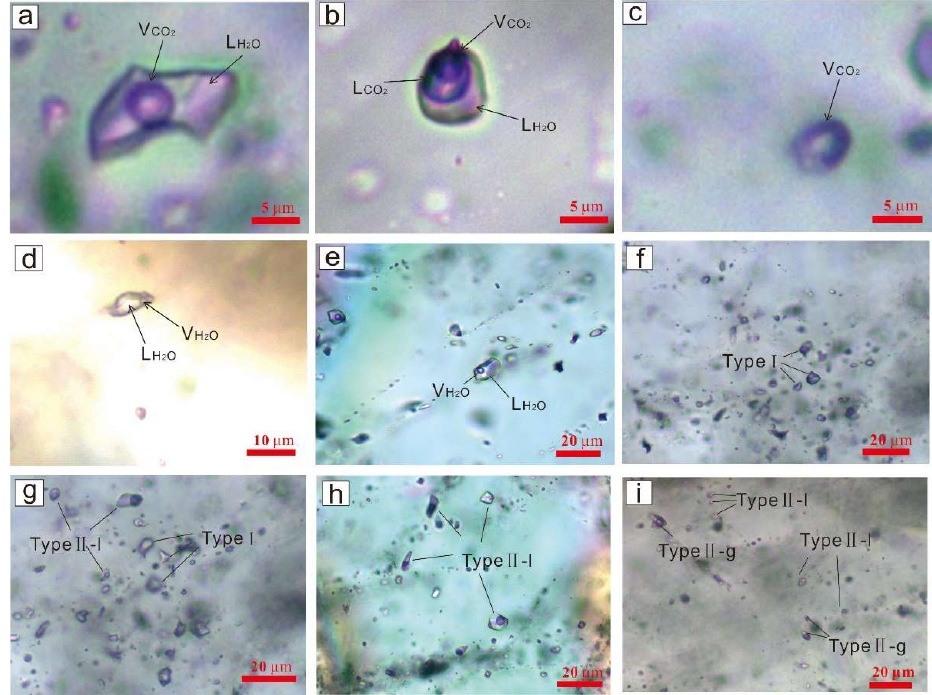
Figure 5. Photomicrographs of typical fluid inclusions in the Sanshandao gold deposit. ( a ) Type II inclusion consisting of two (H 2 O liquid + CO 2 vapor/liquid) phases; ( b ) type II inclusion consisting of three (H 2 O liquid + CO 2 liquid + CO 2 vapor) phases; ( c ) type I inclusion consisting of pure gas (CO 2 vapor) phase; ( d ) type III inclusion consisting of two (H 2 O liquid + H 2 O vapor) phases; ( e ) fluid-inclusion assemblage (FIA) consists of secondary type III inclusions; ( f ) FIA consists of type 1 inclusions; ( g ) FIA consists of type I and type II-l inclusions occurring together in stage 2 quartz; ( h